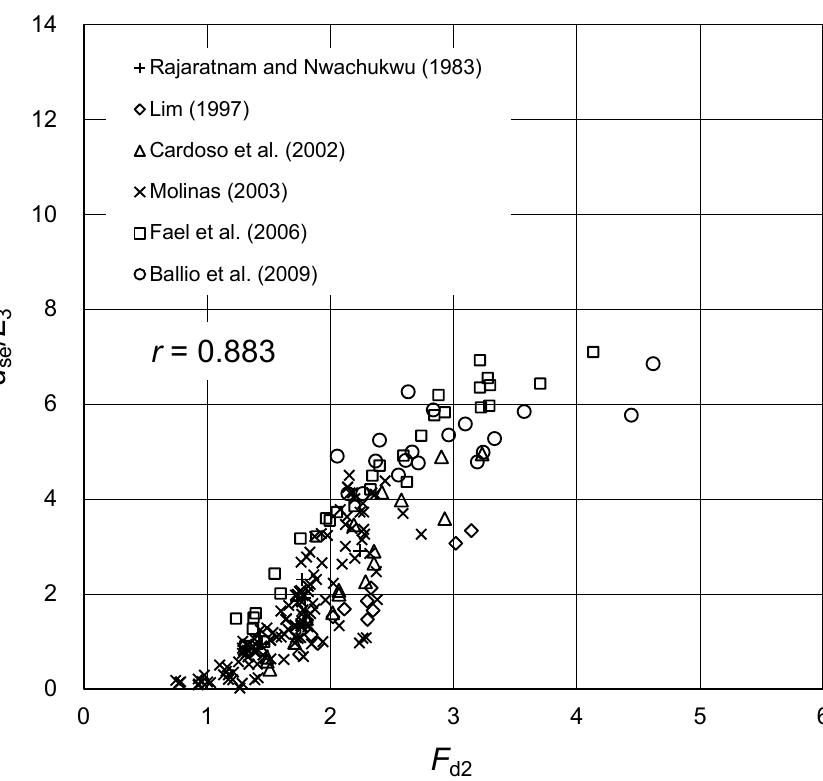
/(cid:1838) against (cid:1832) (cid:3046)(cid:3032) (cid:2870)